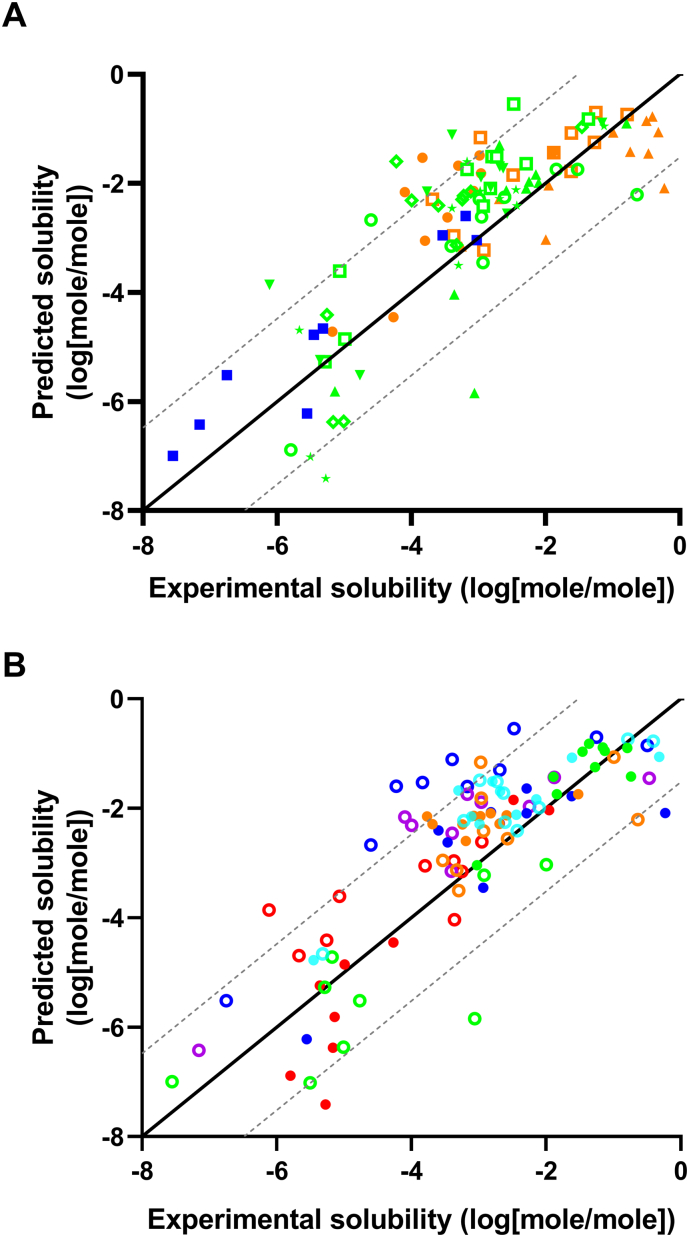
A) Predicted vs. experimental solubility for all 11 APIs in Image 5water, Image 6glycerol, Image 7ethanol, Image 8PEG 300 and the six different DESs (Image 9CU, Image 10CG, Image 11BGW, Image 12CGluW, Image 13LGluW, and Image 14CLW). The black solid line illustrates the ideal fit and the grey dotted line represents the expected 0.95 confidence interval of the computational predictions. Slope of best linear fit = 0.90, intercept = 0.053, R2 = 0.68. RMSE = 1.044. B) Predicted vs. experimental solubility plotted according to API. Image 15Aprepitant, Image 16celecoxib, Image 17cinnarizine, Image 18flufenamic acid, Image 19ibuprofen, Image 20indomethacin, Image 21lidocaine, Image 22naproxen, Image 23paracetamol, Image 24probucol, and Image 25theophylline.